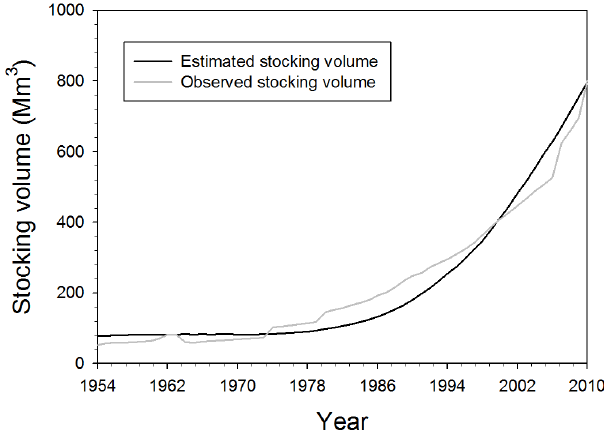
Figure 4. The time series of the estimated and observed (statistical data) stocking volume in South Korean forests during the simulation period. The observed stocking volumes of each year were compiled from those published by the Korea Forest Service in the Statistical Yearbook of